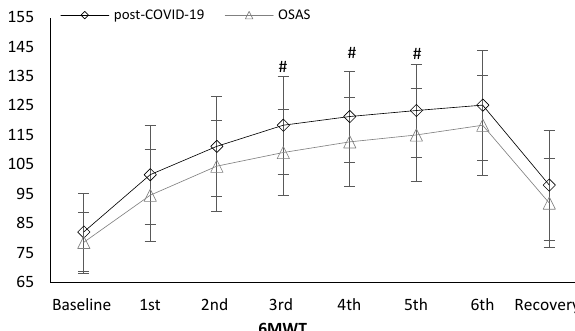
Figure 1. Heart rate alteration during the 6-minute walk test (6MWT) between the groups. # < 0.005.